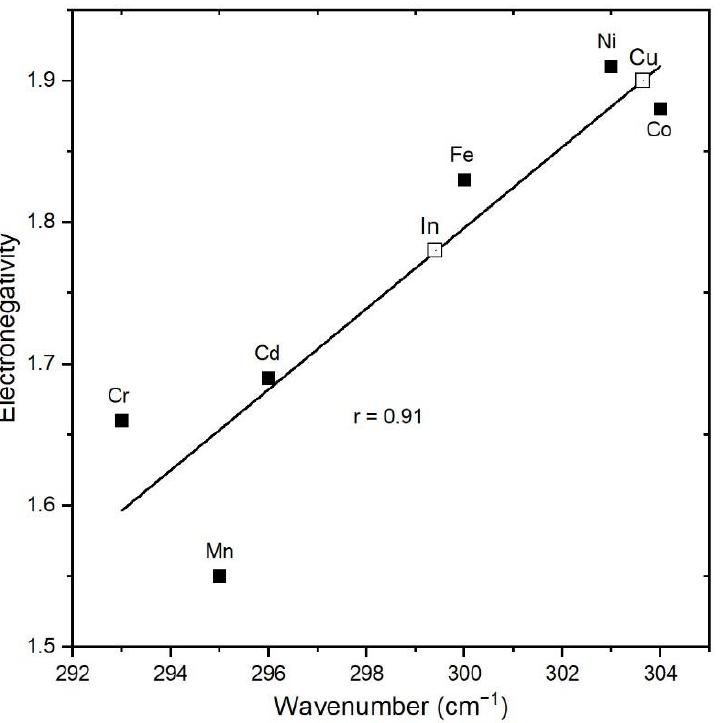
Figure 5. Electronegativity of different divalent ions that substitutes Zn in sphalerite lattice sites vs. the Raman mode position of the consequent metal–sulfide bond.